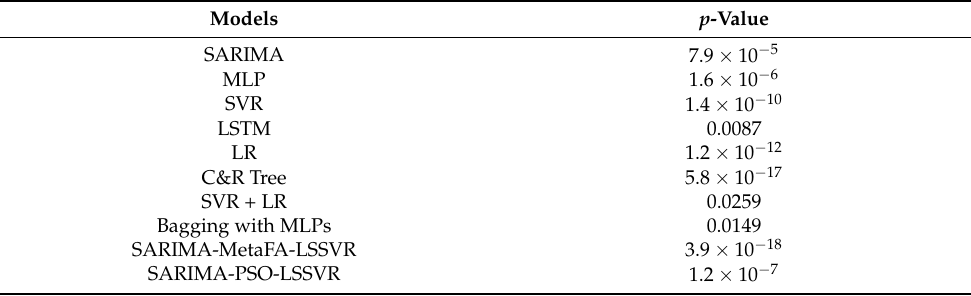
Table 5. p -values of the Diebold-Mariano statistical test comparing the proposed hybrid system with the literature